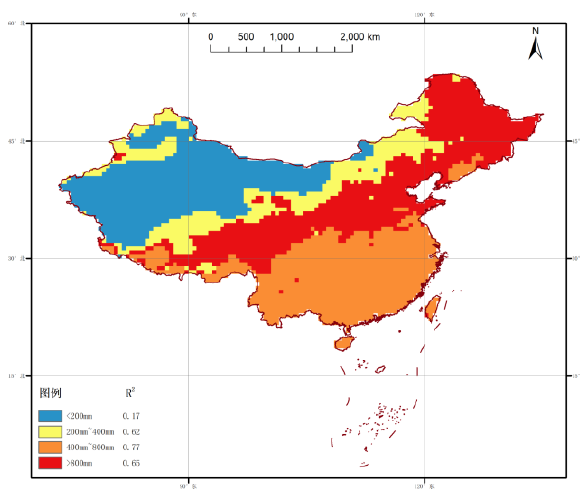
Figure 2. The relationship between SIF and GPP is analysed in four levels of annual total precipitation used simple linear regression